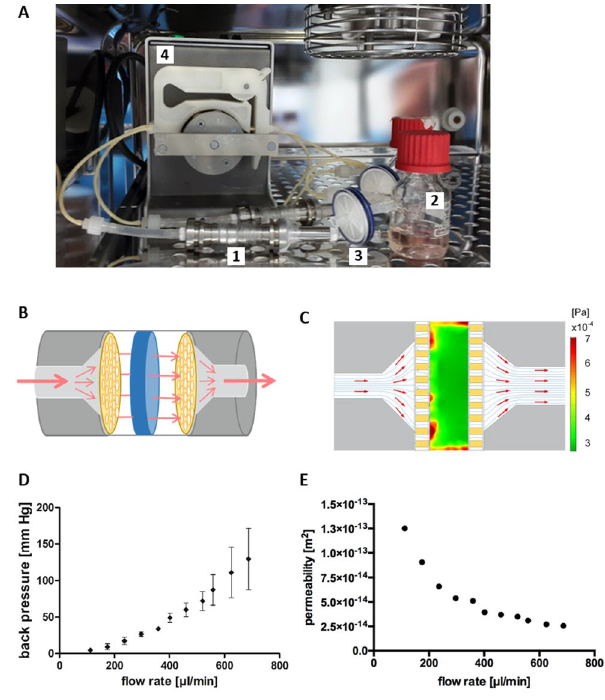
Figure 1. Perfusion of macroporous scaffolds in the bioreactor. ( A ) Experimental setup of perfusion reactors harboring macroporous scaffolds inside an incubator. 1: perfusion reactor; 2: medium reservoir; 3: ventilation filter; 4: peristaltic pump. ( B ) Schematic drawing of the macroporous hydrogel within the bioreactor. The medium is led unidirectional (red arrow) via perforated plates (yellow) through the macroporous hydrogel (blue). ( C ) Computational fluid dynamics of perfused bioreactor (sectional view). The perforated plate is depicted in yellow, flow direction is shown by red arrows and stream lines (blue), and flow-derived shear stress is indicated by color range. ( D ) The back pressure (depicted on the y-axis) in front of the macroporous hydrogel was monitored in dependency of the flow rate (x-axis). N = 3 independent experiments. ( E ) The computational fluid flow model was harnessed to extract data on hydrogel permeability at increasing flow rates. Permeability is shown on the y-axis and flow rates on the